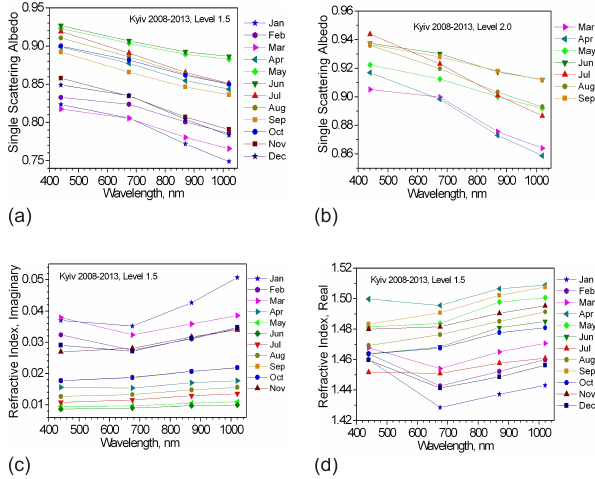
Figure 6. (a and b) Single-scattering albedo, and (c and d) refractive index spectral dependence by the Kyiv AERONET site